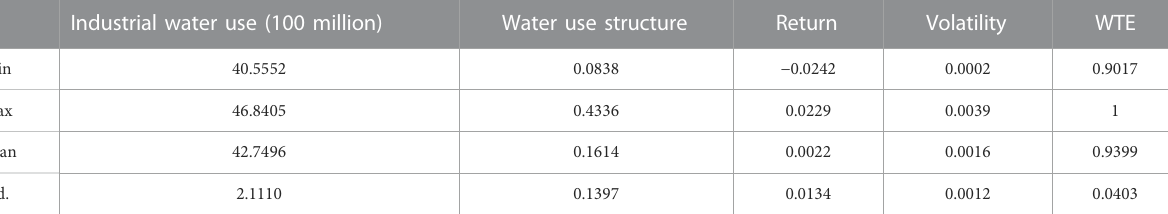
TABLE 3 Descriptive statistics for Japan. Industrial water use (100